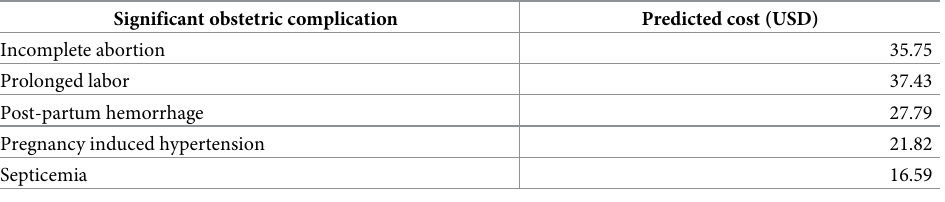
Table 6. Predicted cost of significant obstetric complication from fitted